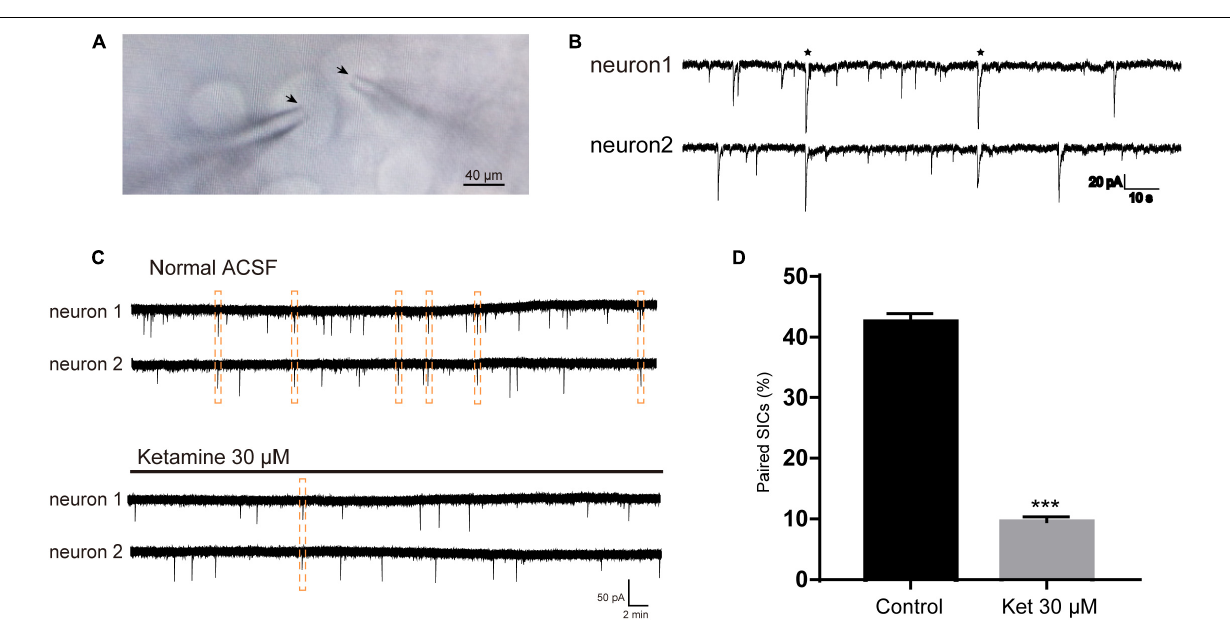
FIGURE 3 | Ketamine inhibit synchronized SICs from pair-recorded PFC neurons. (A) Infrared chromatic aberration photo of pair-recorded PFC neurons. Tips of glass microelectrodes were marked with arrow. (B) Example traces showed synchronized SICs in two different PFC neurons recorded simultaneously. Two pairs of synchronized SICs were marked by asterisks. (C) Example large scale traces of synchronized SICs exposed to normal ACSF and 30 µ M ketamine, synchronized SICs were marked by dashed box. (D) Statistical summary of the occurrence rate of paired SICs. Differences with statistically significant ( ∗∗∗ p < 0.001, compared with control) were verified by unpaired t -test. Data were presented as mean ±